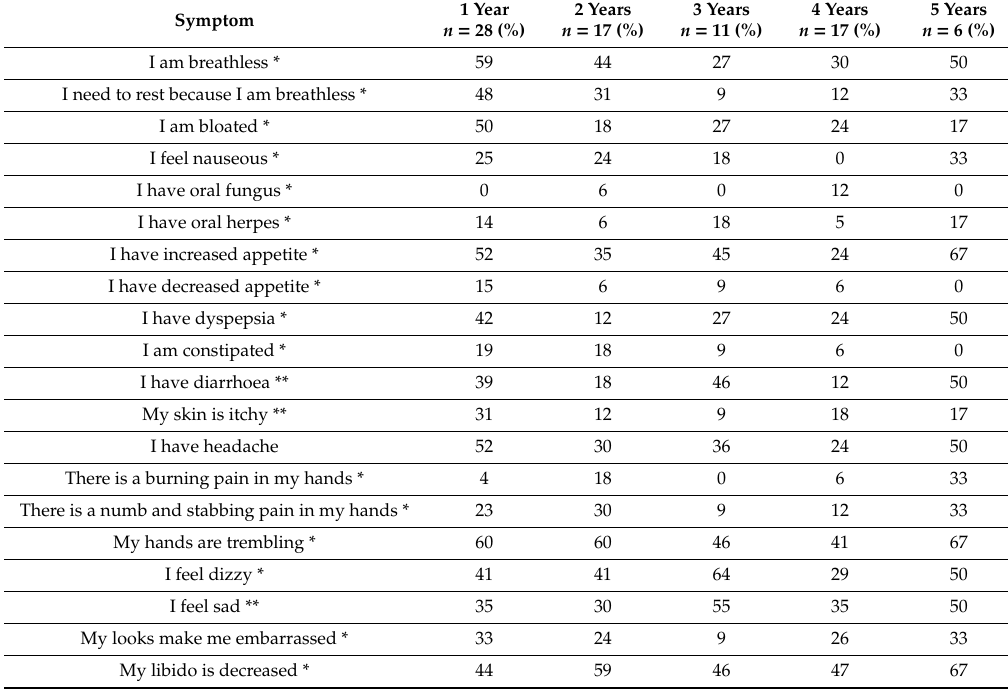
Table 3. Symptom occurrence separated on follow-up among 79 heart recipients reporting some degree of symptom